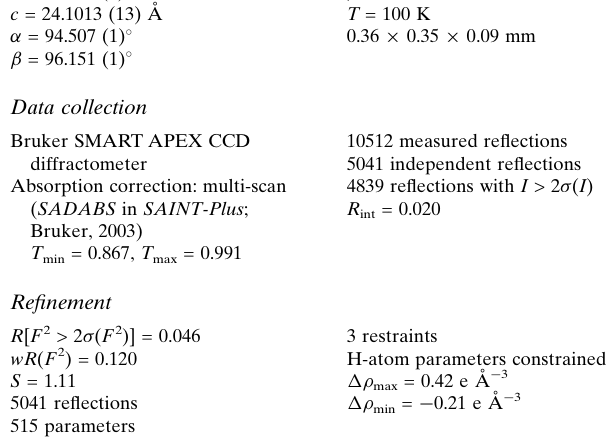
Bruker SMART APEX CCD diffractometer Absorption correction: multi-scan ( SADABS in SAINT-Plus ;